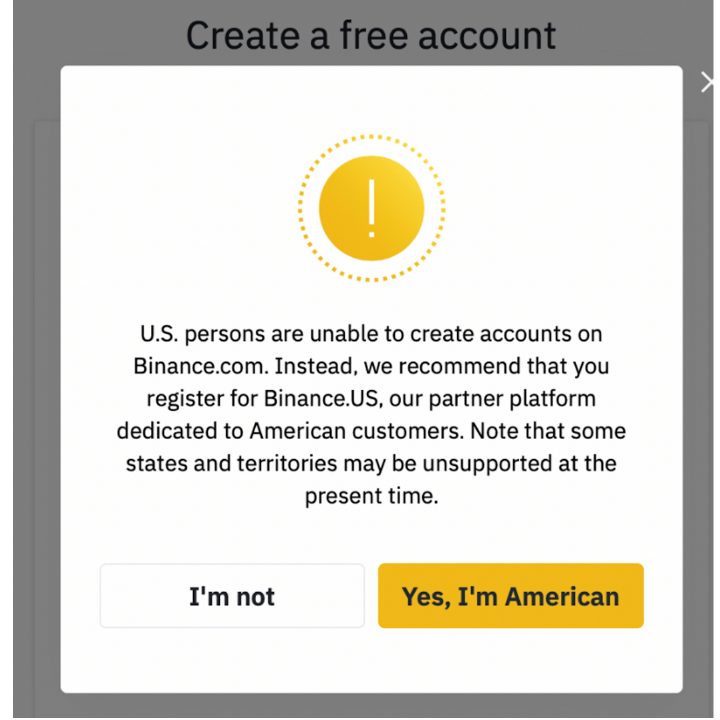
Figure 2: A Cryptocurrency Exchange Platform’s Locating of